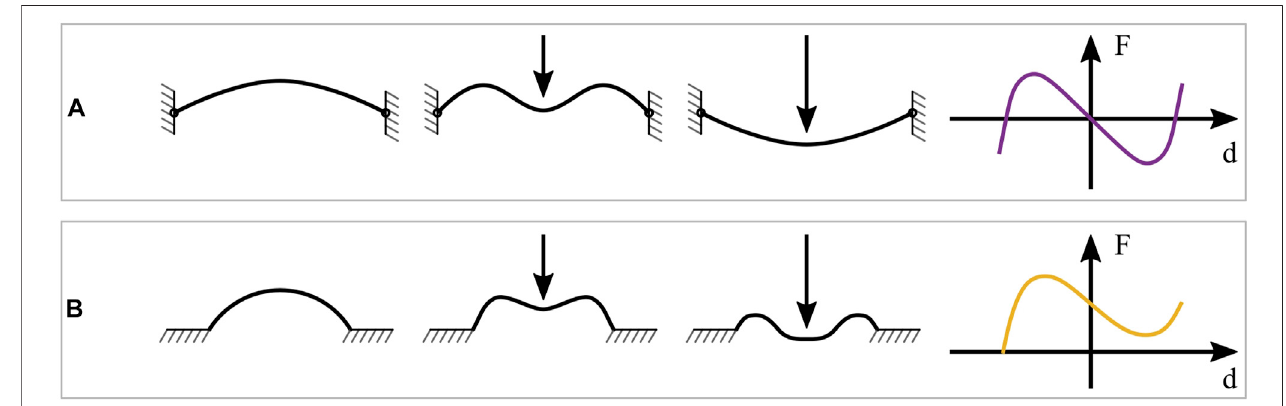
FIGURE 4 | Different realizations of bi-stable mechanisms. (A) pre-compressed buckled beam, snapping behavior under a load and corresponding force- displacement curve. (B) polymeric dome, snapping behavior under a load and corresponding force-displacement curve.